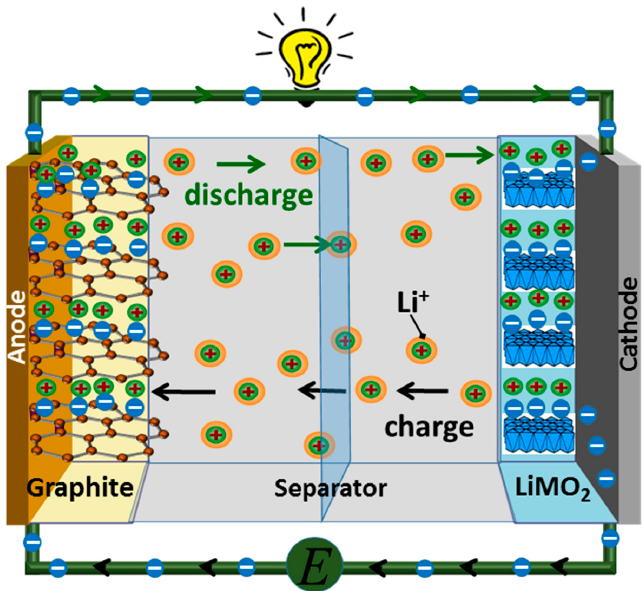
Figure 2. Schematic of the operation principles for rechargeable lithium ion batteries.